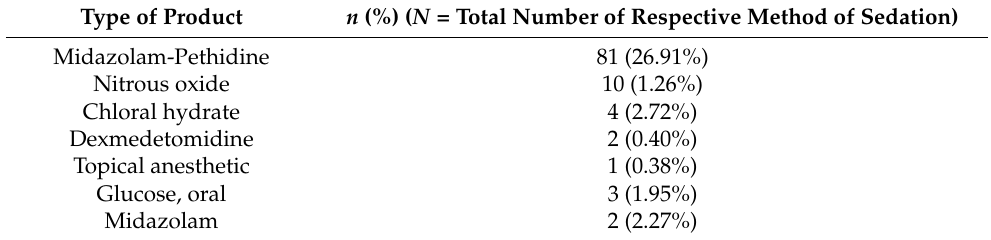
Table 11. Occurrence of adverse event according to method of sedation used.